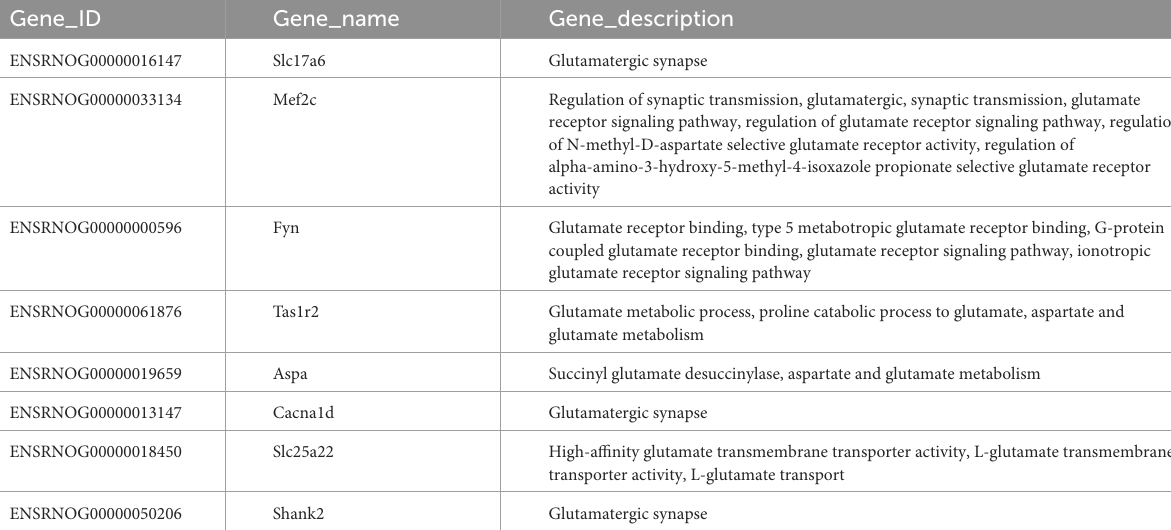
TABLE 3 Differential mRNAs and functional annotations related to the glutamatergic system in